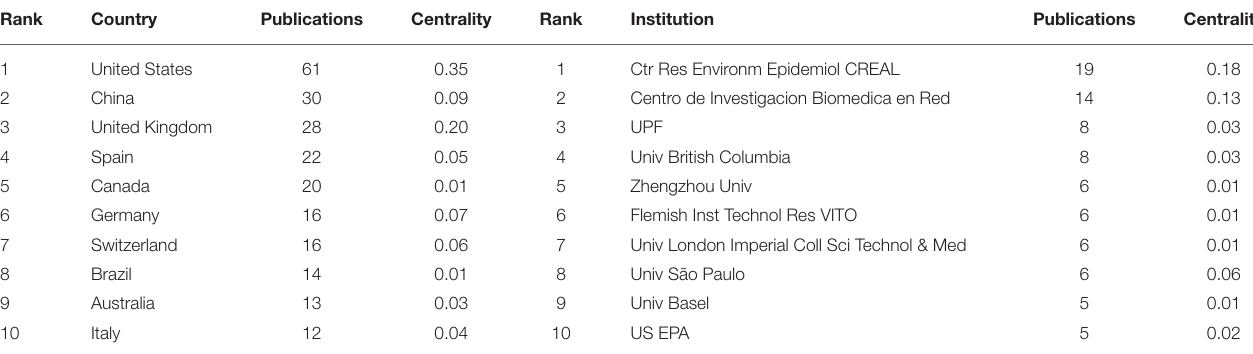
TABLE 1 | Ranking of top 10 countries and institutions of pieces of air pollution-physical exercise (AP-PE) research. Rank Country Publications Centrality Rank Institution Publications